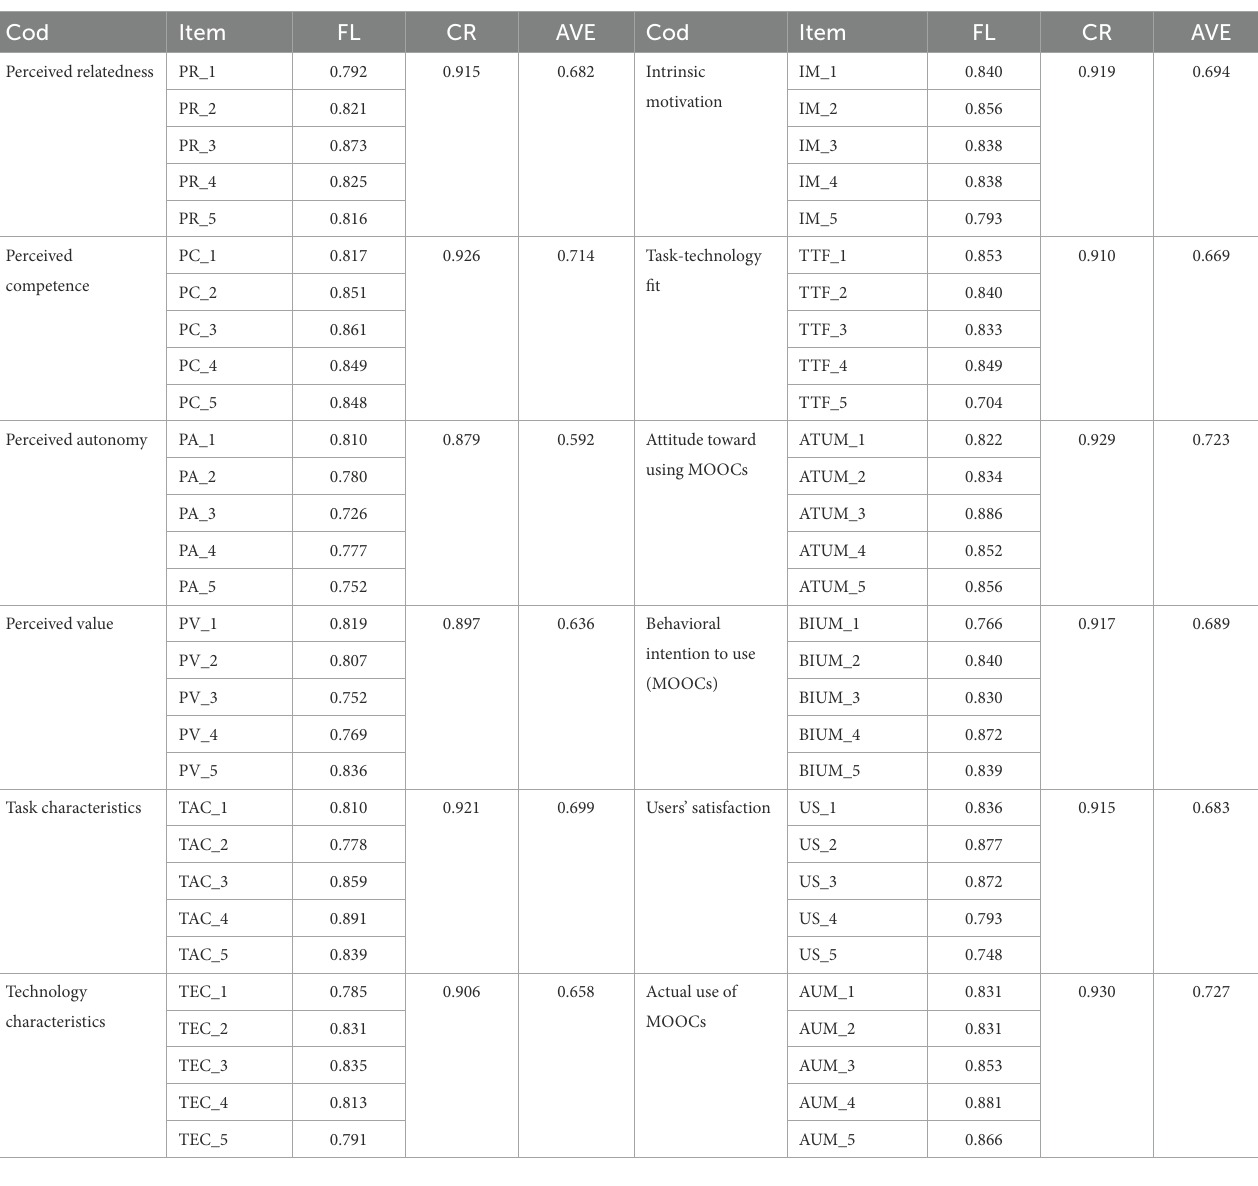
TABLE 2 Reliability analysis, CR, FL for the research variables.